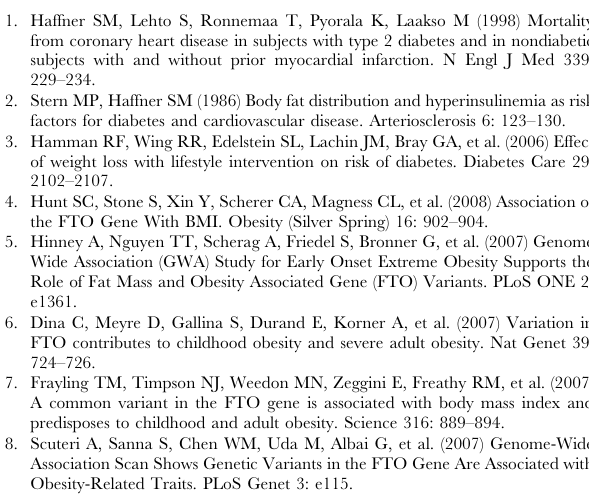
Table S3 Prevalence odds ratios for diabetes and obesity case status detectable at 80% power stratified by